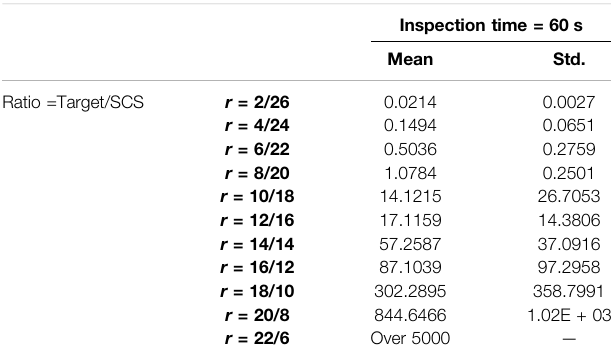
TABLE 3 | Second test summarized results.